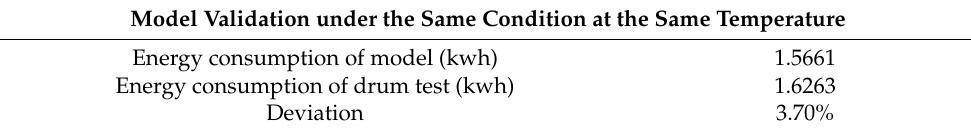
Table 3. Energy consumption comparison of the model and the car.